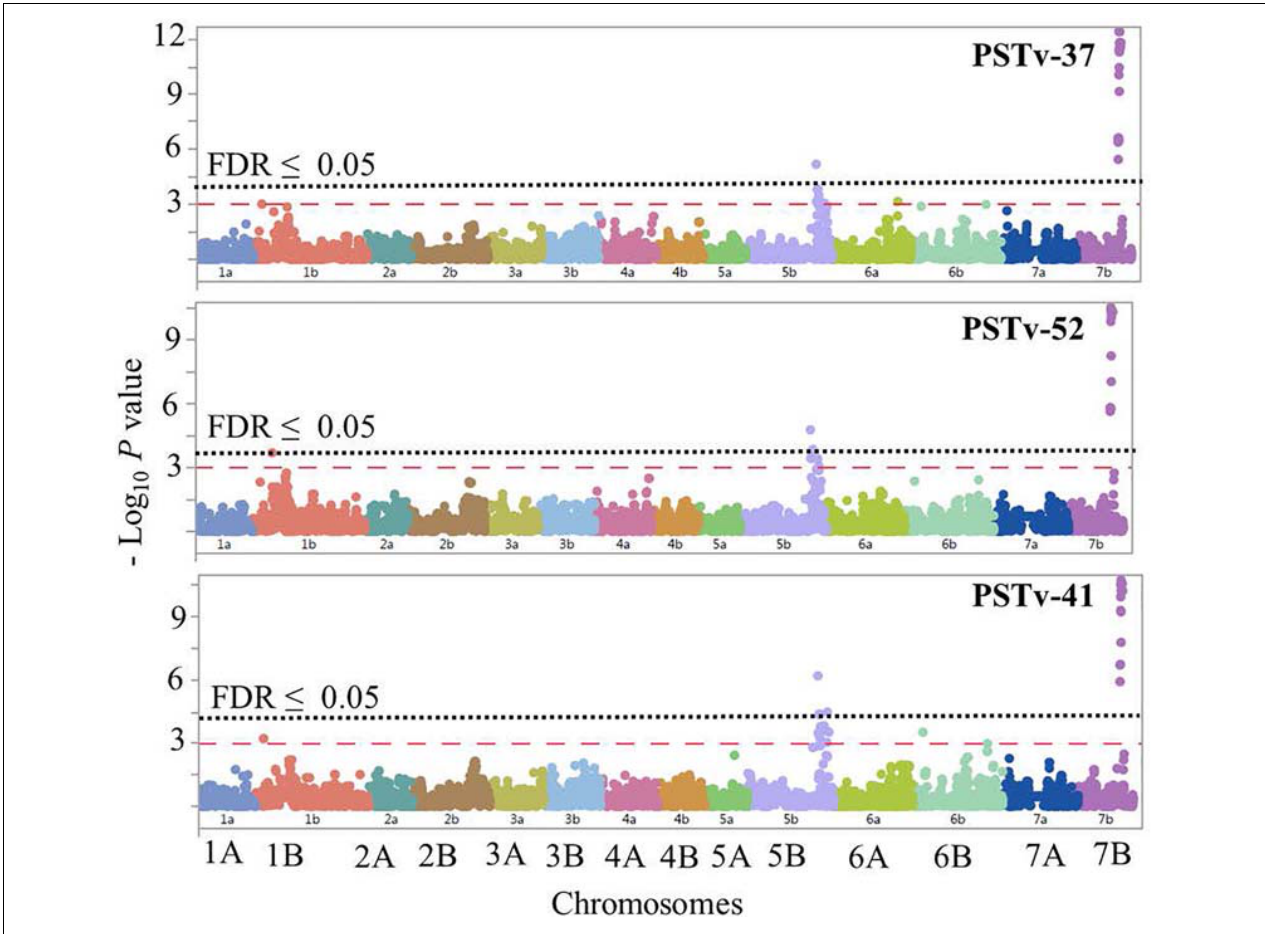
FIGURE 7 | Manhattan plots showing P -values for single-nucleotide polymorphism (SNP) markers associated with response to stripe rust in durum wheat genotypes to the three Pst isolates PSTv-37, PSTv-52, and PSTv-41. The horizontal dashed red line indicates significance level at P -value ≤ 0.001. The horizontal dotted black line indicates significance level at FDR ≤